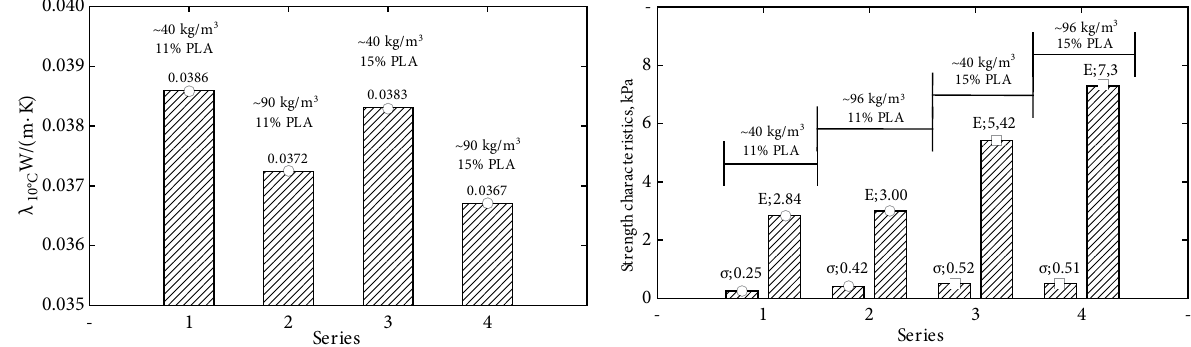
Fig. 2. Thermal conductivity coefficient of hemp fibre composites